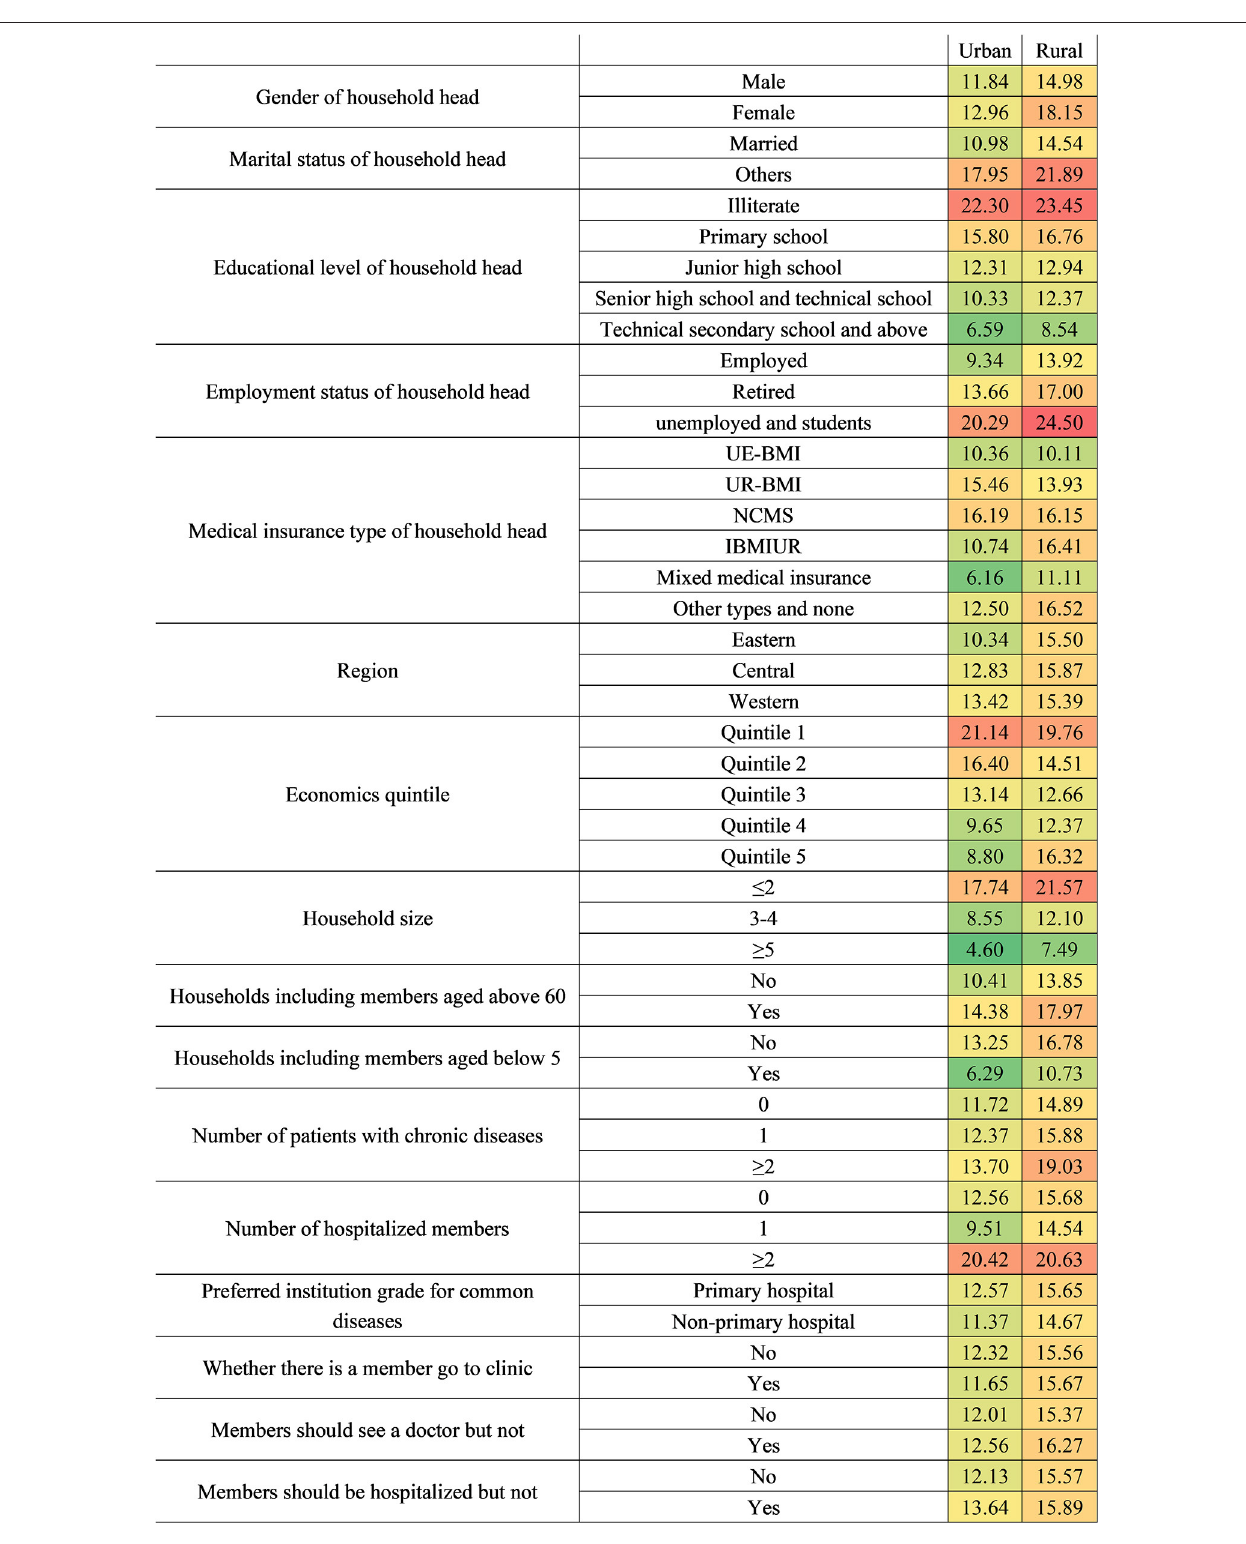
FIGURE 5 | Factors affecting CHE by different locations of